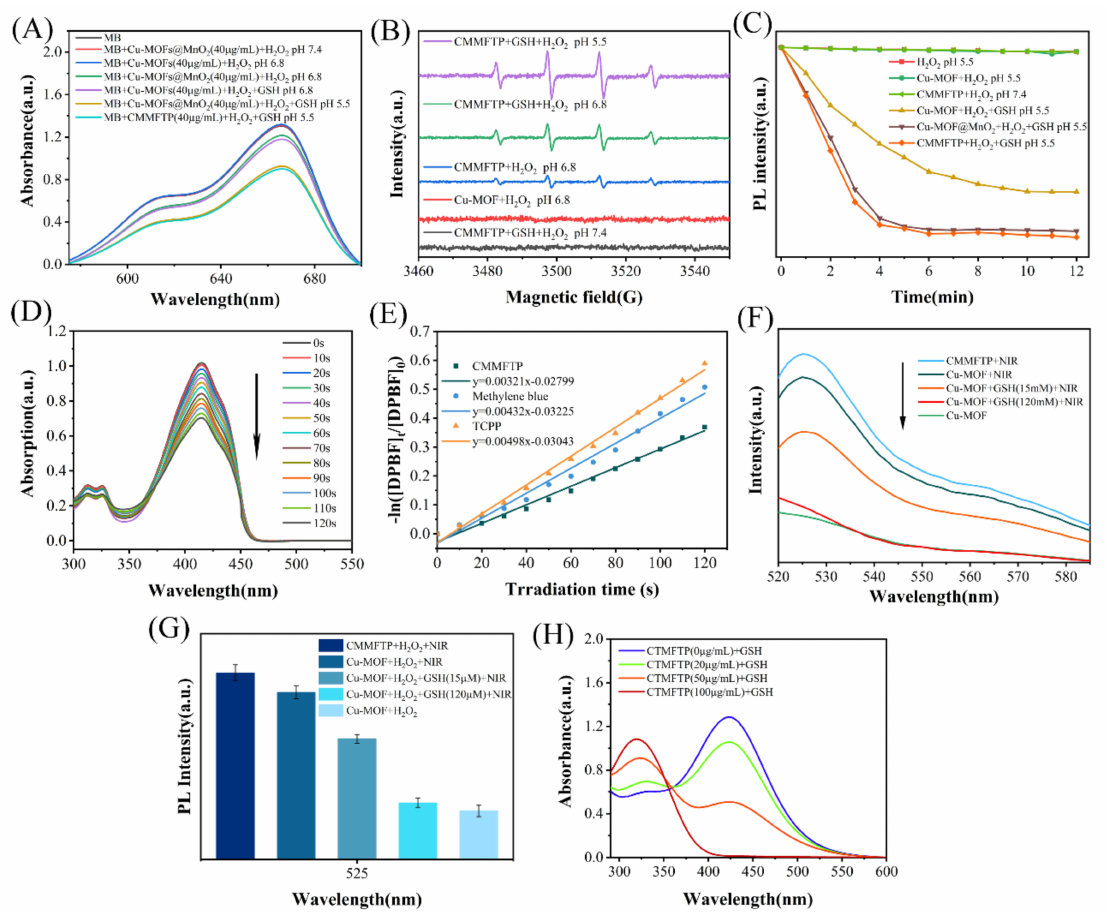
Figure 2. ( A ) Detection of • OH generation capacity of various samples using MB; ( B ) • OH detection by ESR signals under different conditions; ( C ) detection of O 2 production capacity of various samples using RDPP as a dissolved oxygen probe; ( D ) examine the ability of CMMFTP photosensitization to produce 1 O 2 using DPBF as singlet oxygen indicator probe; ( E ) standard curves of degradation